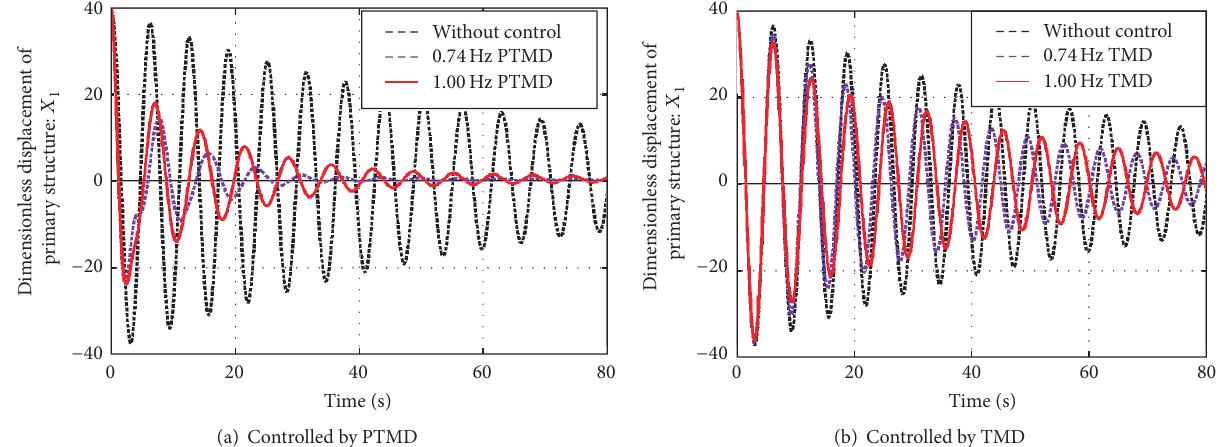
Figure 10: Control performance of PTMD and TMD in free vibration excitation.